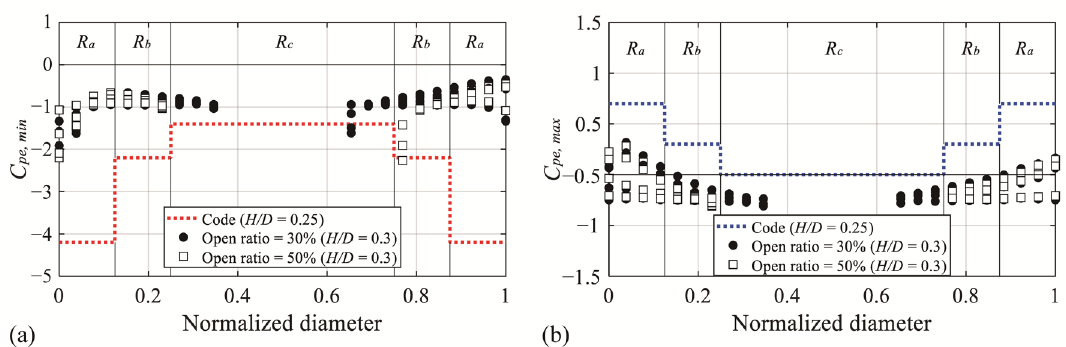
Figure 17. Comparison of the external peak pressure coefficients of AIJ-RLB (2015): ( a ) C pe,min and ( b ) C pe,max .